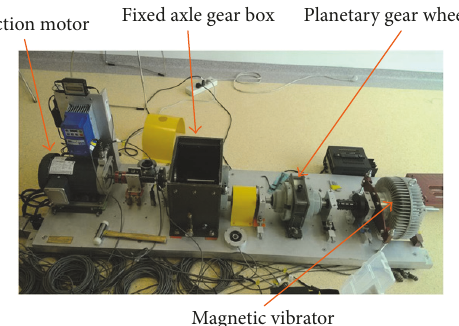
Figure 16: Machinery fault simulator- (MFS-) magnum experimen- tal platform.